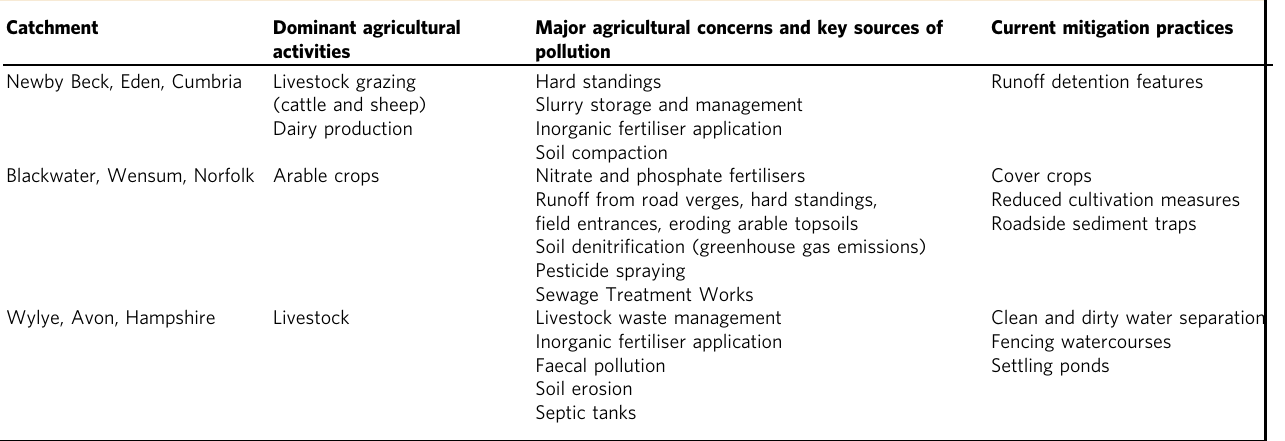
Table 1 Major agricultural practices and pollution concerns for three catchments in the UK